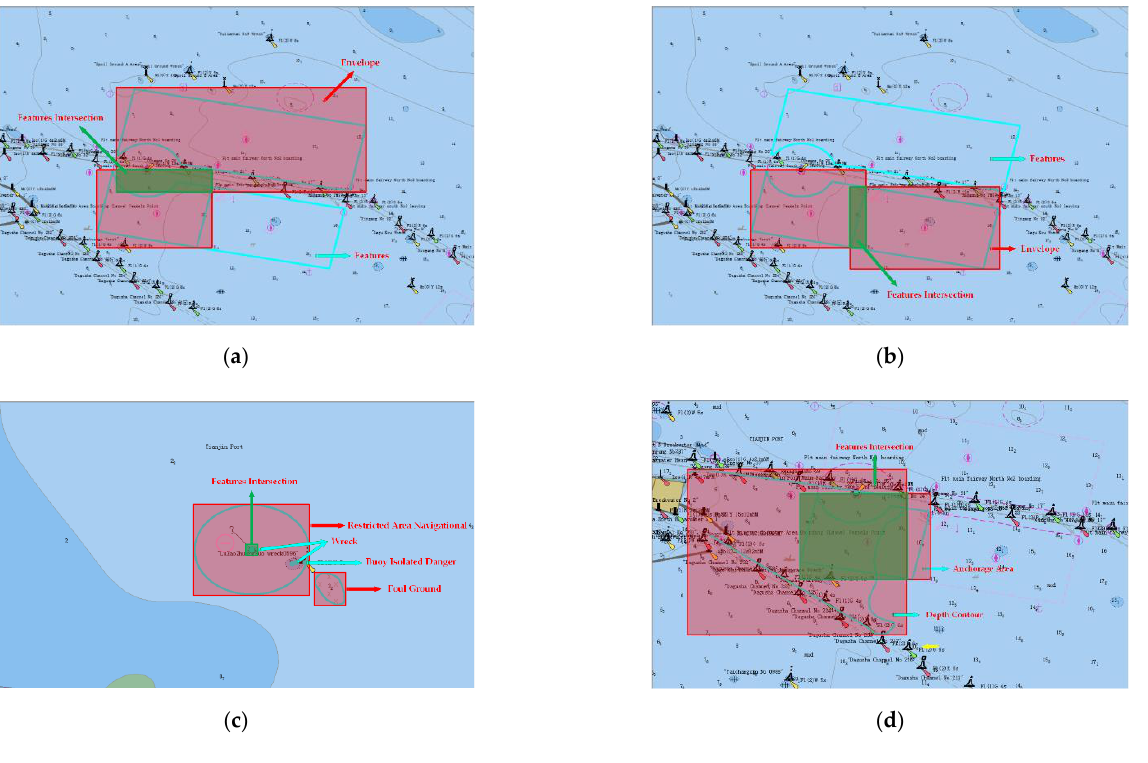
Figure 6. Intersection of features. ( a ) The envelope of the same type features; ( b ) The features intersection of the same type; ( c ) The envelope of the different type features; ( d ) The features intersection of different types.